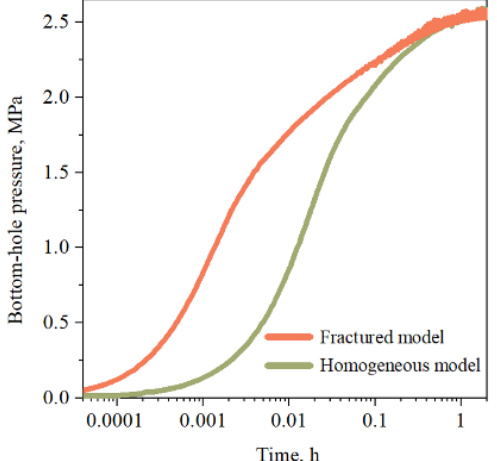
Figure 19. Comparison of the bottom-hole pressure from the fractured model and homogeneous model.